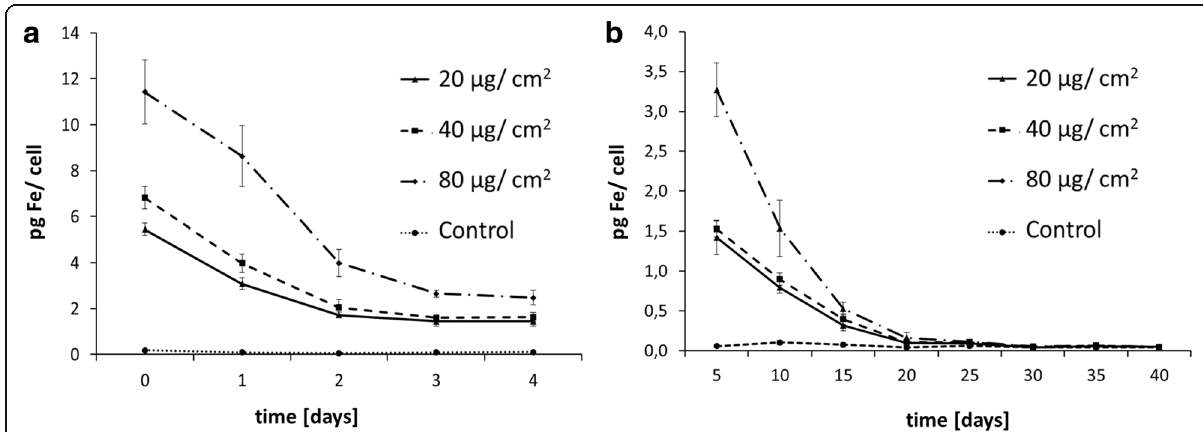
Fig. 4 Iron clearance in long- and short-term measurements. Absolute iron content per cell was analyzed using MP-AES. a Iron content in VFFs was quantified daily for 4 days. Time point 0 represents the iron load 24 h after the addition of SPIONs. *** p ≤ 0.0001 (details in Table 1). ( b ) After 40 days, iron content in VFFs reached same level as the control group. * p ≤ 0.05, ** p ≤ 0.001, *** p ≤ 0.0001 (details in Table